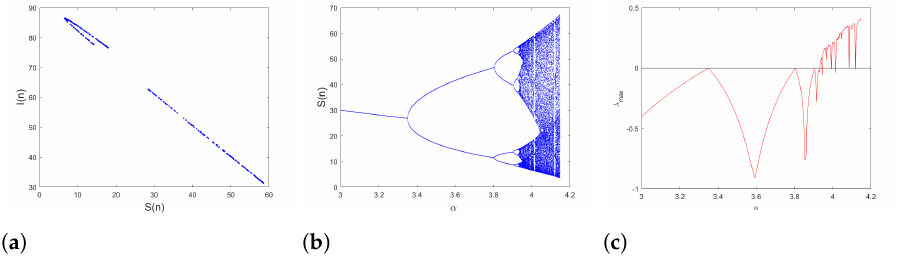
Figure 2. ( a ) Phase space of the discrete SIR epidemic model with vaccination (4) for α = 4, β = 0.8, σ = 0.1, p = 0.005, N = 100, and initial conditions ( S ( 0 ) , I ( 0 )) = ( 70,30 ) . ( b ) Bifurcation diagram of the SIR epidemic model (4) versus α . ( c ) The maximum Lyapunov